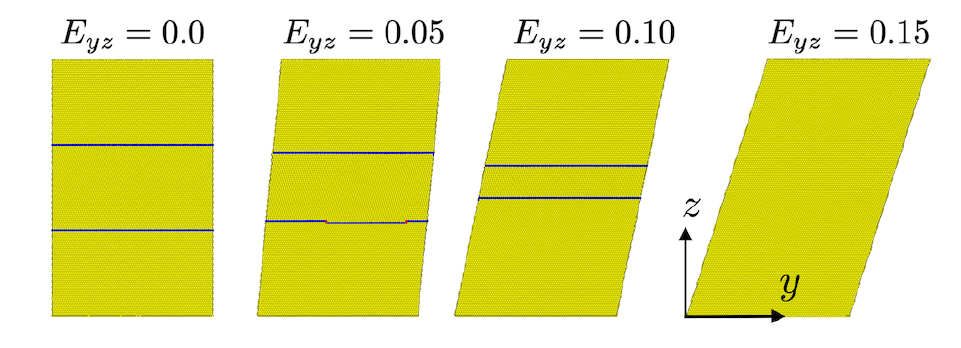
Figure 5. Twin boundary motion and detwinning during T yz loading corresponding to the stress-strain behavior shown in Figure 3 (bottom